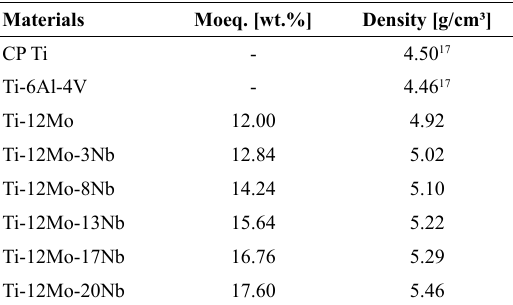
Table 1. Density and mass composition of alloys in molybdenum equivalence (Moeq.)